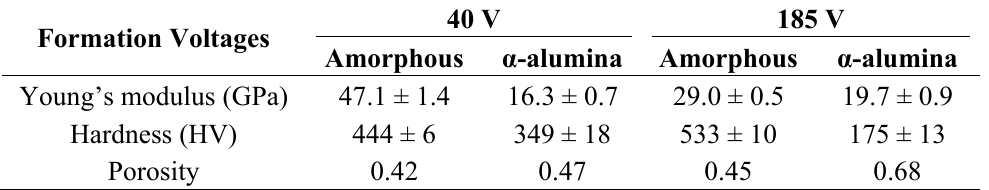
Figure 9. Load-displacement curves for the amorphous and α -alumina membranes formed in ( a ) oxalic acid at 40 V and ( b ) phosphoric acid at 185 V. Nanoindentation was performed with a 980 mN (100 gf) load and a dwell time of 15 s. Table 2. Relationship between the porosity, hardness, and Young’s modulus of the alumina membranes formed via anodizing at different voltages. Anodizing was conducted under the same conditions as those described in Table